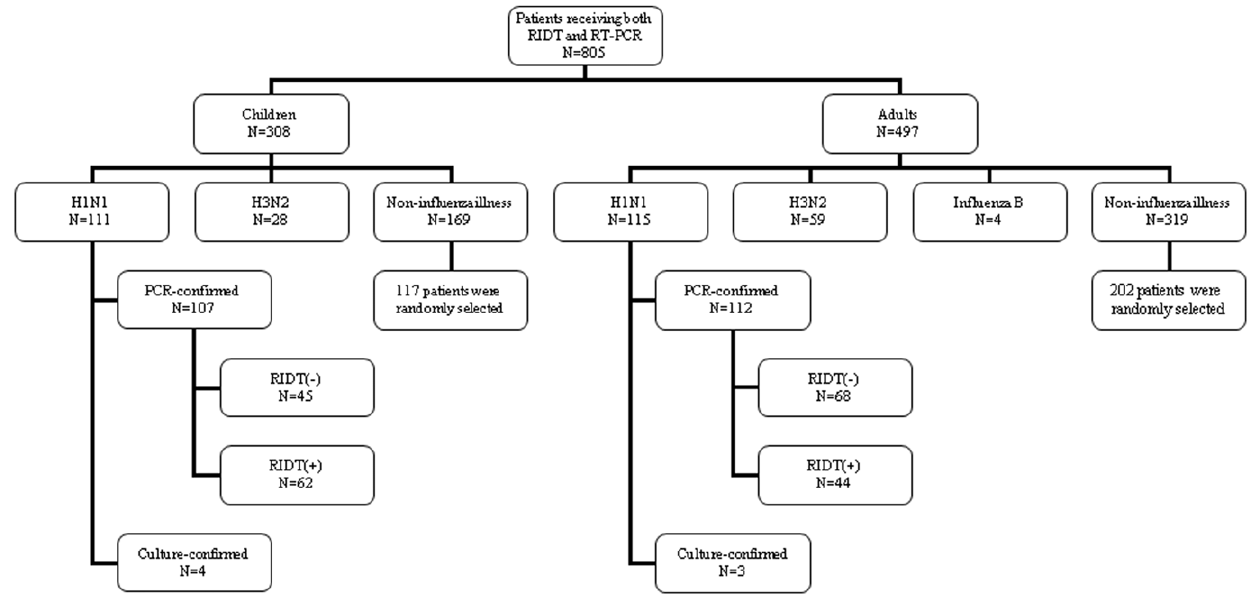
Figure 1. Flow chart of patient inclusion, including 226 cases of 2009 influenza A virus (H1N1) infection and 319 cases of non- influenza controls. RIDT, rapid influenza diagnostic test; RT-PCR, reverse transcriptase polymerase chain reaction.